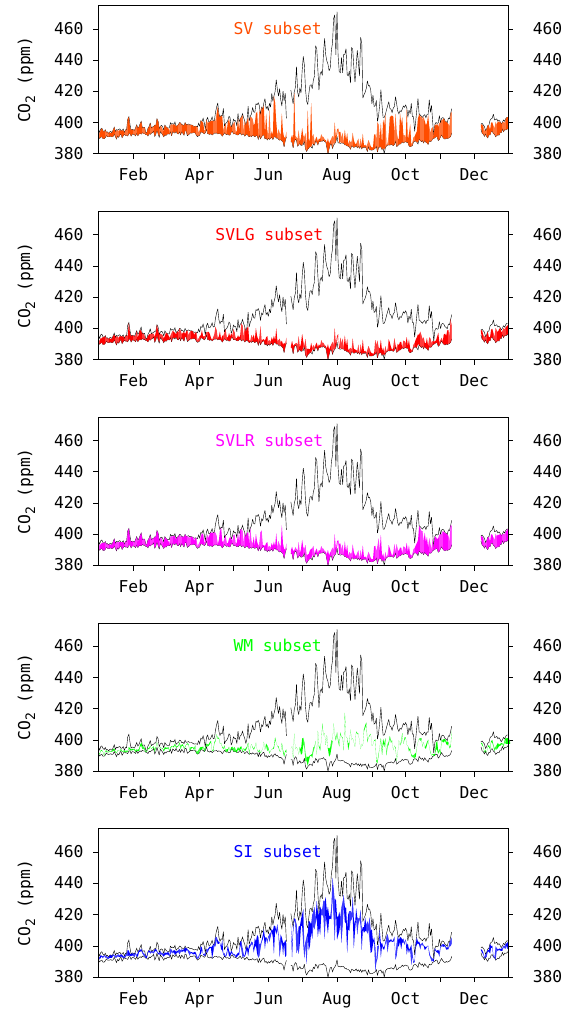
Fig. 9 that represent RACCOON measurements with lapse Fig. 8. Extracting useful observations from a “difficult-to-model”